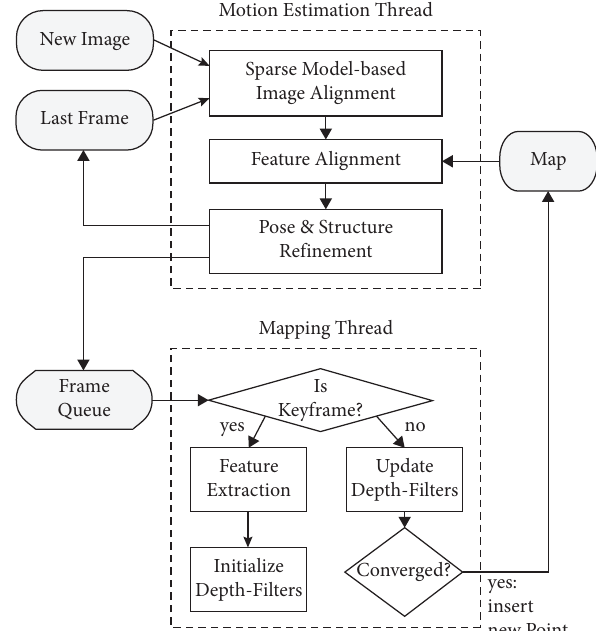
Figure 13: SVO2.0 fow chart, excerpt from paper [78].